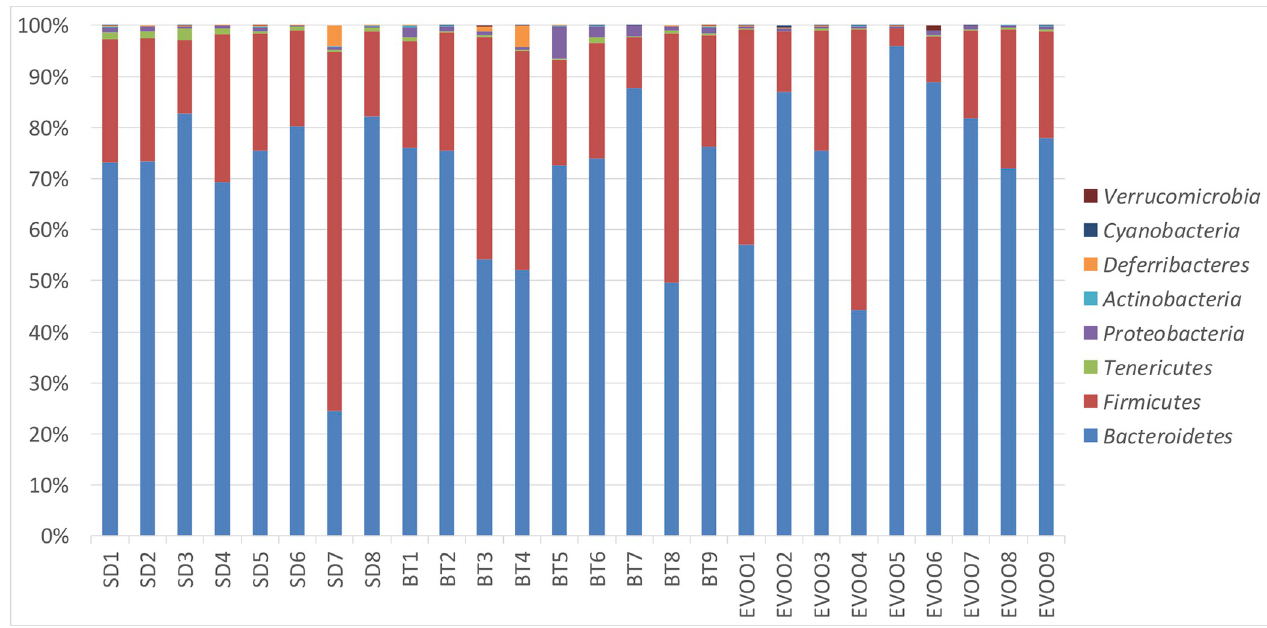
Fig 1. Global bacterial phyla distribution for each diet as a percentage of total sequences after 6 weeks of treatment. Each column corresponds to one animal fed a diet enriched with butter (BT), virgin olive oil (EVOO) or standard chow (SD). Legend shows upwards the eight phyla detected.